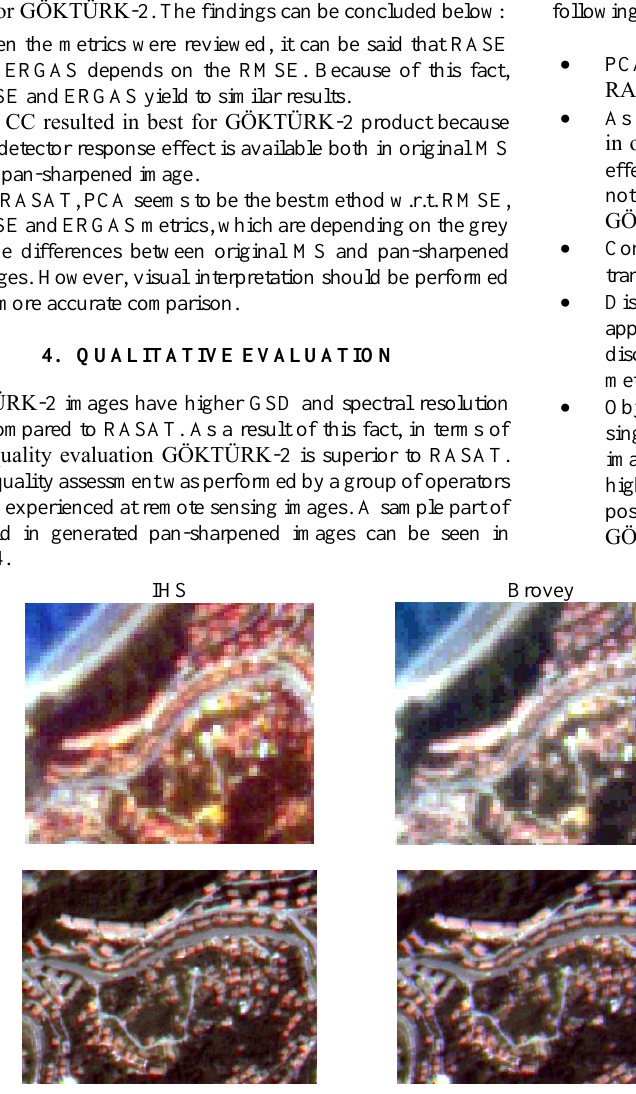
Figure 4. A sample part of the test field in pam-sharpened